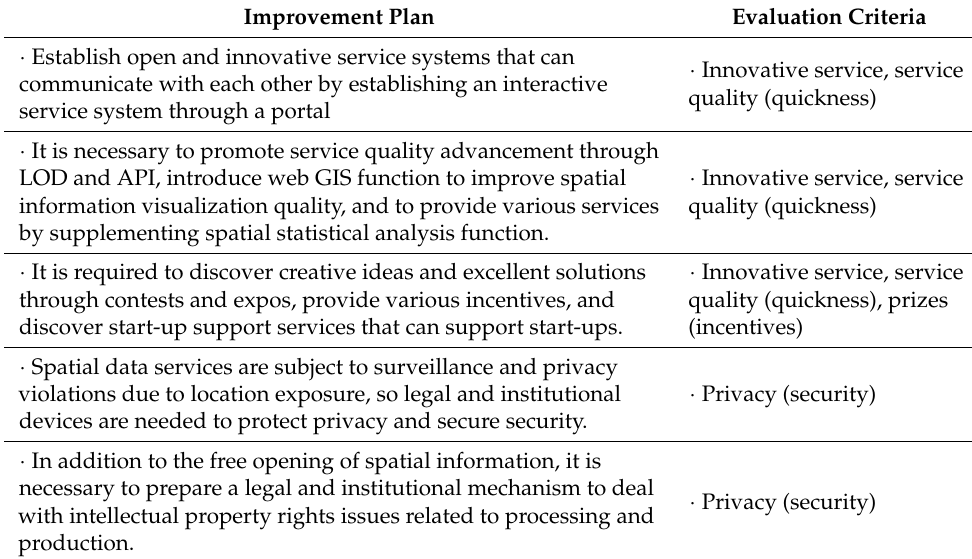
Table 8. Improvement plan of civil petition